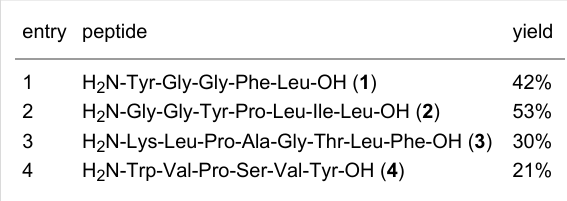
Table 1: Peptides synthesized by SPPS mediated by FPID. entry